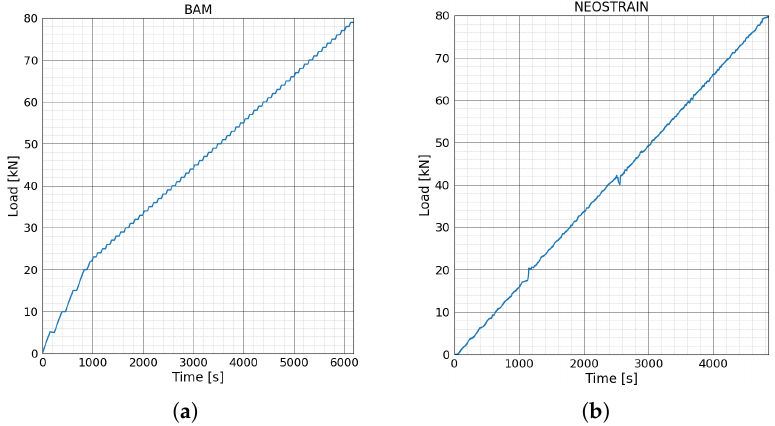
Figure 8. Loading steps of four points bending test at ( a ) BAM and at ( b ) NEOSTRAIN.